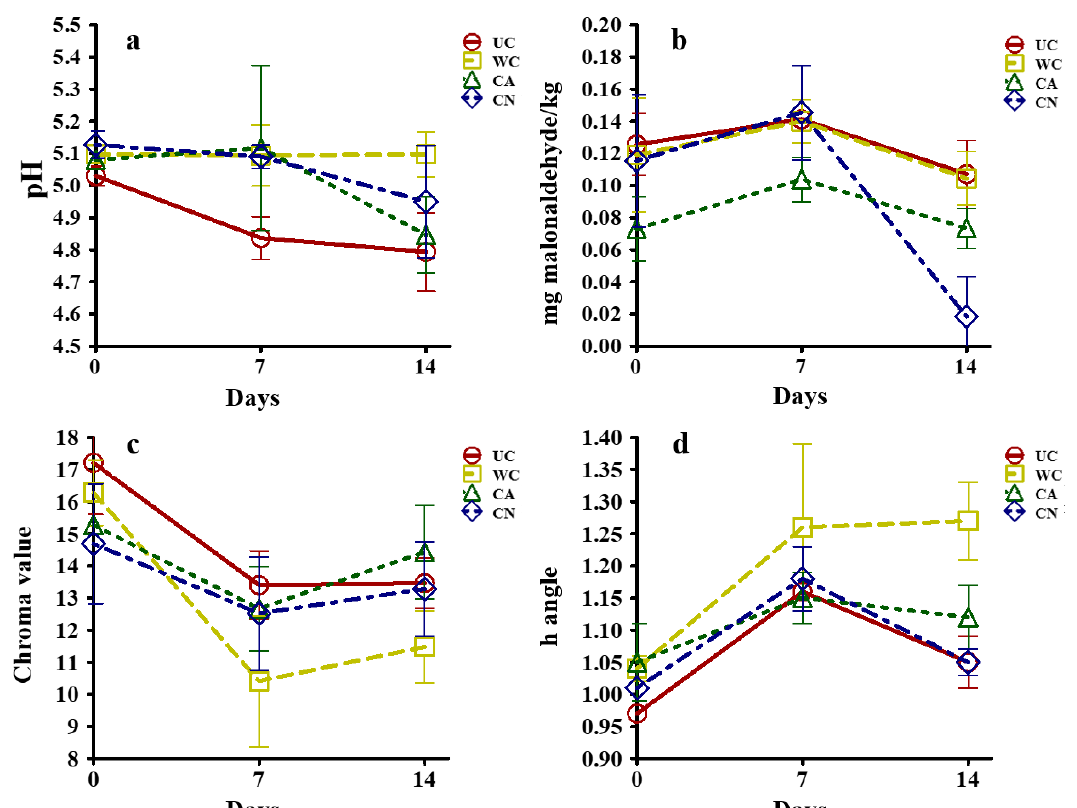
Figure 6. Effect of edible coatings on fresh beef physical and chemical properties. ( a ) Effect on pH; ( b ) Effect on TBARS (mg malonaldehyde/kg meat); ( c ) Effect on chroma value; ( d ) Effect on h-angle. UC: control sample without coating; WC: coated sample without any addition; CA: coated sample added with emulsified oregano essential oil (OEO); CN: coated sample added with mesoporous silica nanoparticles loaded with oregano essential oil (MSNO).